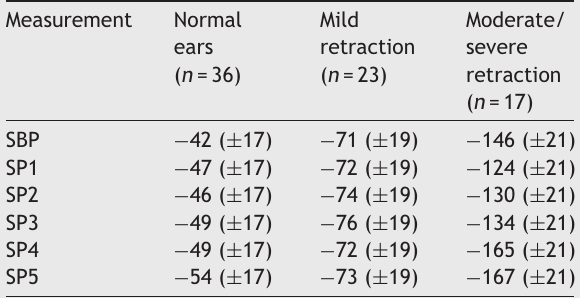
Estimated means obtained with a linear mixed model for the sniff test in the three study groups, at the second time point of assessment.